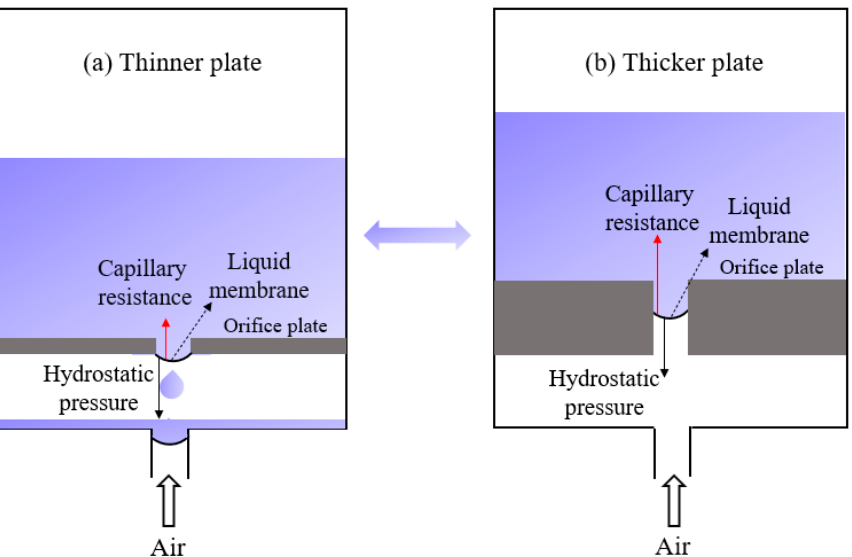
Figure 8. Schematic diagram of the effect of plate thickness on liquid movement when shutting off air supply. air